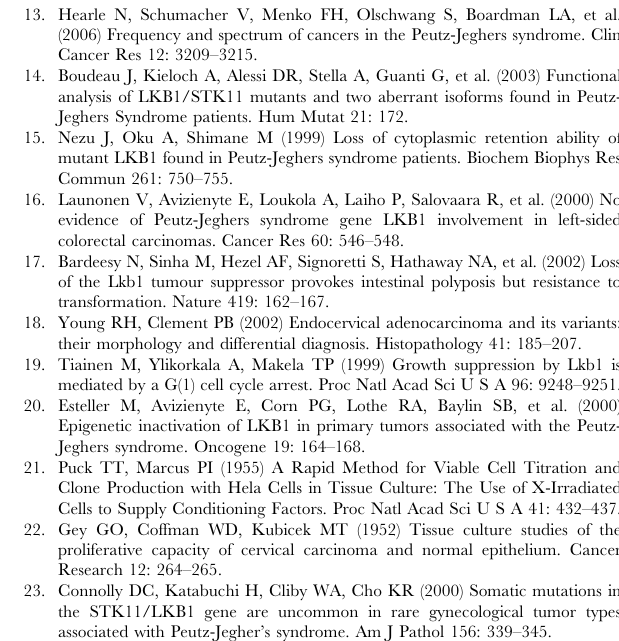
Figure S1 Cloning and characterization of LKB1 intragenic deletion breakpoints in HeLa/HeLaS3. A 2.8 kb fragment spanning the deletion breakpoint was cloned from HeLa DNA